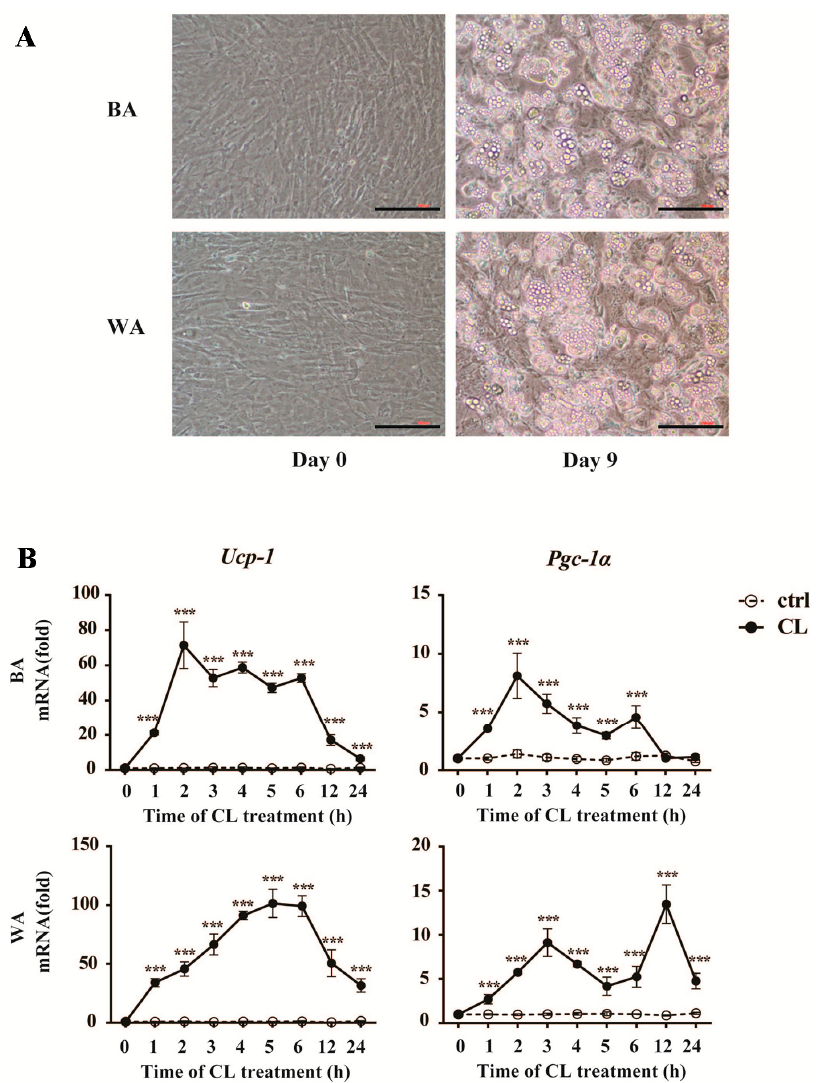
Figure 4. Browning transition with increase of browning markers in the cultured mature Brown Adipocyte (BA) and White Adipocyte (WA) after CL316,243 treatment. ( A ) Morphology of the brown and white adipocytes before (Day 0) and after (Day 9) the differentiation. The mature adipocytes after nine days of differentiation were used for CL316,243 treatment. Scale bar: 200 µm; ( B ) Quantitative PCR analysis of Ucp-1 and Pgc-1 α gene expression in cultured mice brown and white adipocytes after CL316,243 treatment up to 24 h. The data show the fold changes of the expression for the target genes in BA and WA at Hour 0. Values are mean ± S.E.M. from three independent experiments. The expression of genes is corrected for the housekeeping gene Cyclophilin (*** p < 0.001).